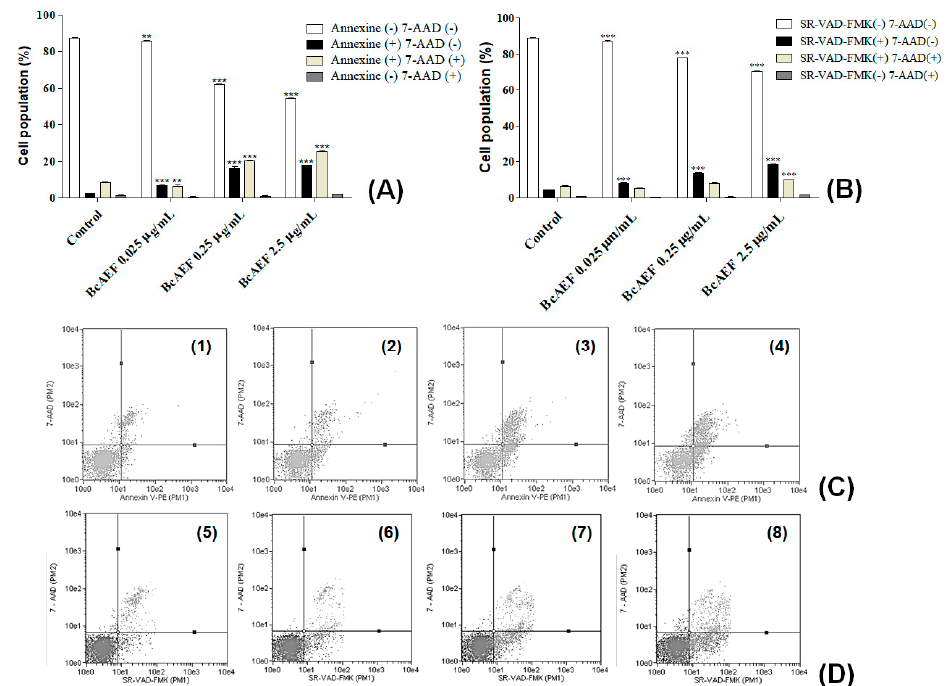
Figure 4. Programmed cell death e ff ects of BcAEF on NCI-H460 cells. ( A ) Influence of BcAEF on phosphatidylserine externalization of NCI-H460 after 36 h of treatment. NCI-H460 cells were treated for 36 h with 0.025, 0.25 and 2.5 µ g mL − 1 of BcAEF. ( B ) Influence of BcAEF on caspases activation of NCI-H460 after 48 h of treatment. NCI-H460 cells were treated for 48 h with 0.025, 0.25 and 2.5 µ g mL − 1 of BcAEF. Statistical analysis for PS externalization and caspases activation: two-way ANOVA followed by Bonferroni test (** p < 0.01 and *** p < 0.001, relative to untreated cells - control). ( C ) Dot-plot graphics of cell distribution after using Annexin-V and 7-AAD dyes over NCI-H460 cells treated for 36 h (Guava Nexin Module): ( 1 ) untreated cells (control), ( 2 ) 0.025 µ g mL − 1 , ( 3 ) 0.25 µ g mL − 1 and ( 4 ) 2.5 µ g mL − 1 of BcAEF. ( D ) Dot-plot graphics of cell distribution after using SR-VAD-FMK and 7-AAD dyes over NCI-H460 cells treated for 48 h (Guava MultiCaspase module): ( 5 ) untreated cells (control), ( 6 ) 0.025 µ g mL − 1 , ( 7 ) 0.25 µ g mL − 1 and ( 8 ) 2.5 µ g mL − 1 of